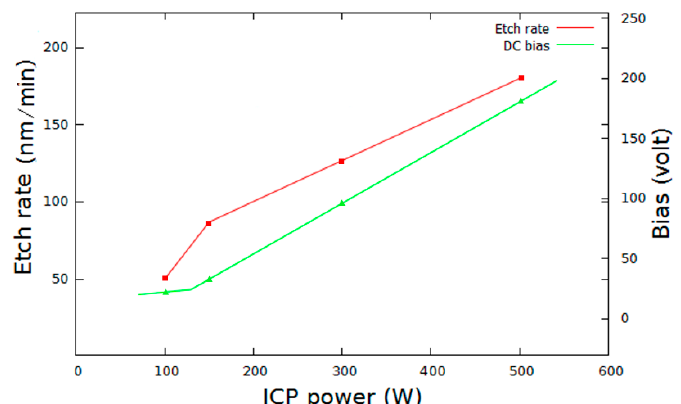
Figure 5. Etch rate of GaN and corresponding DC bias versus ICP power.